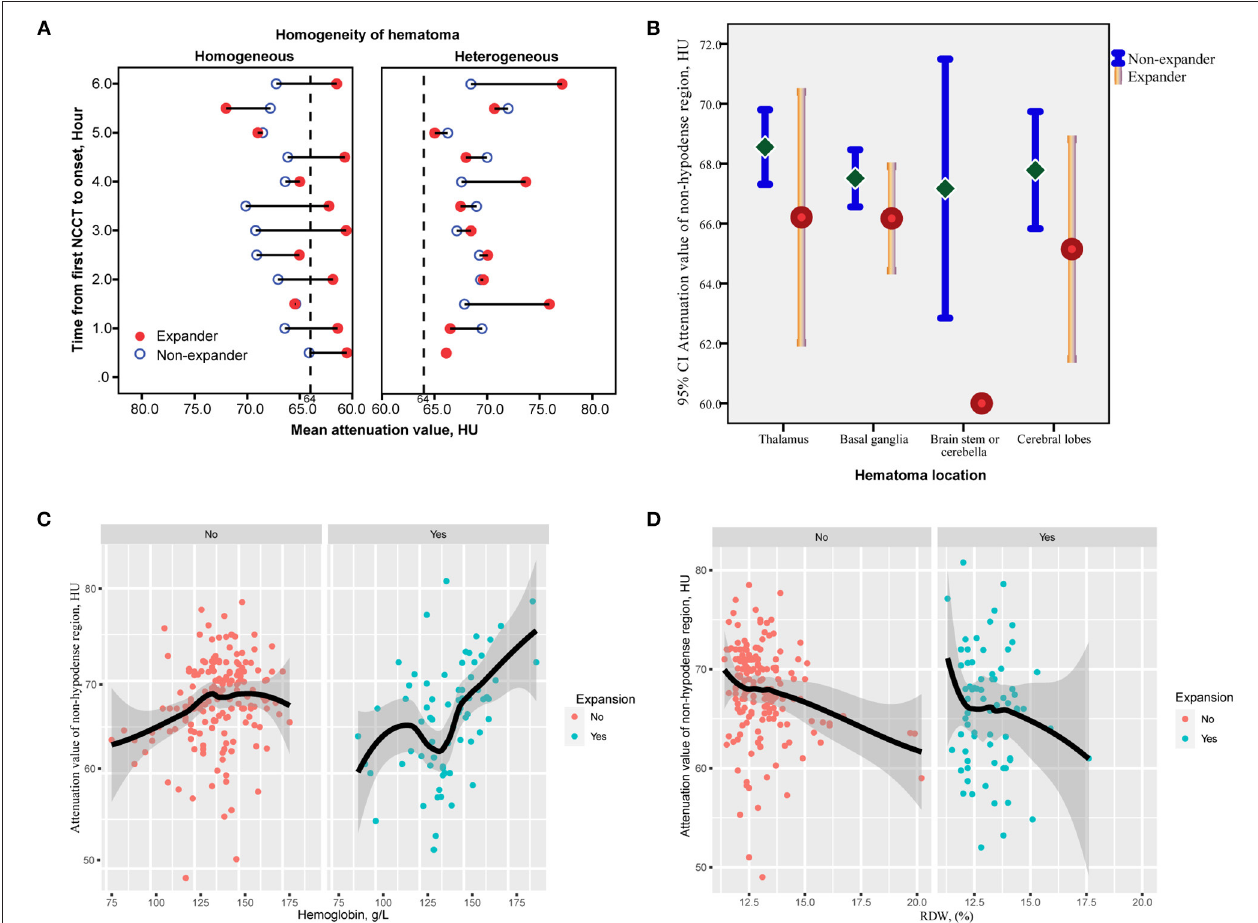
FIGURE 4 | Correlation of the attenuation value of non-hypodense region and time from the first NCCT to onset between hematomas with or without hypodensities. (A) The attenuation value of the non-hypodense region of most expanded hematomas remains lower irrespective of time prolonging, whereas no trend exists between the time and non-hypodense region attenuation value of heterogeneous hematomas. (B) The mean value and 95% CI s of the attenuation value of the non-hypodense region at different cerebral locations. The attenuation value of the non-hypodense region of the cerebellar and brainstem hematomas is the lowest and differs most significantly between expanders and non-expanders. (C,D) Loess analysis of attenuation value and hemoglobin and RDW between expanders and non-expanders. The attenuation value increases with a higher hemoglobin level, but with a lower RDW. HU, Hounsfield units; RDW, red blood cell distribution